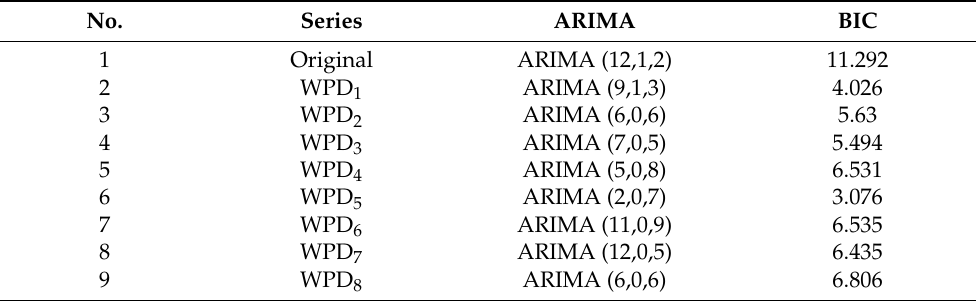
Table 3. Auto-regressive integrated moving average (ARIMA) models based on BIC(Bayes informa- tion